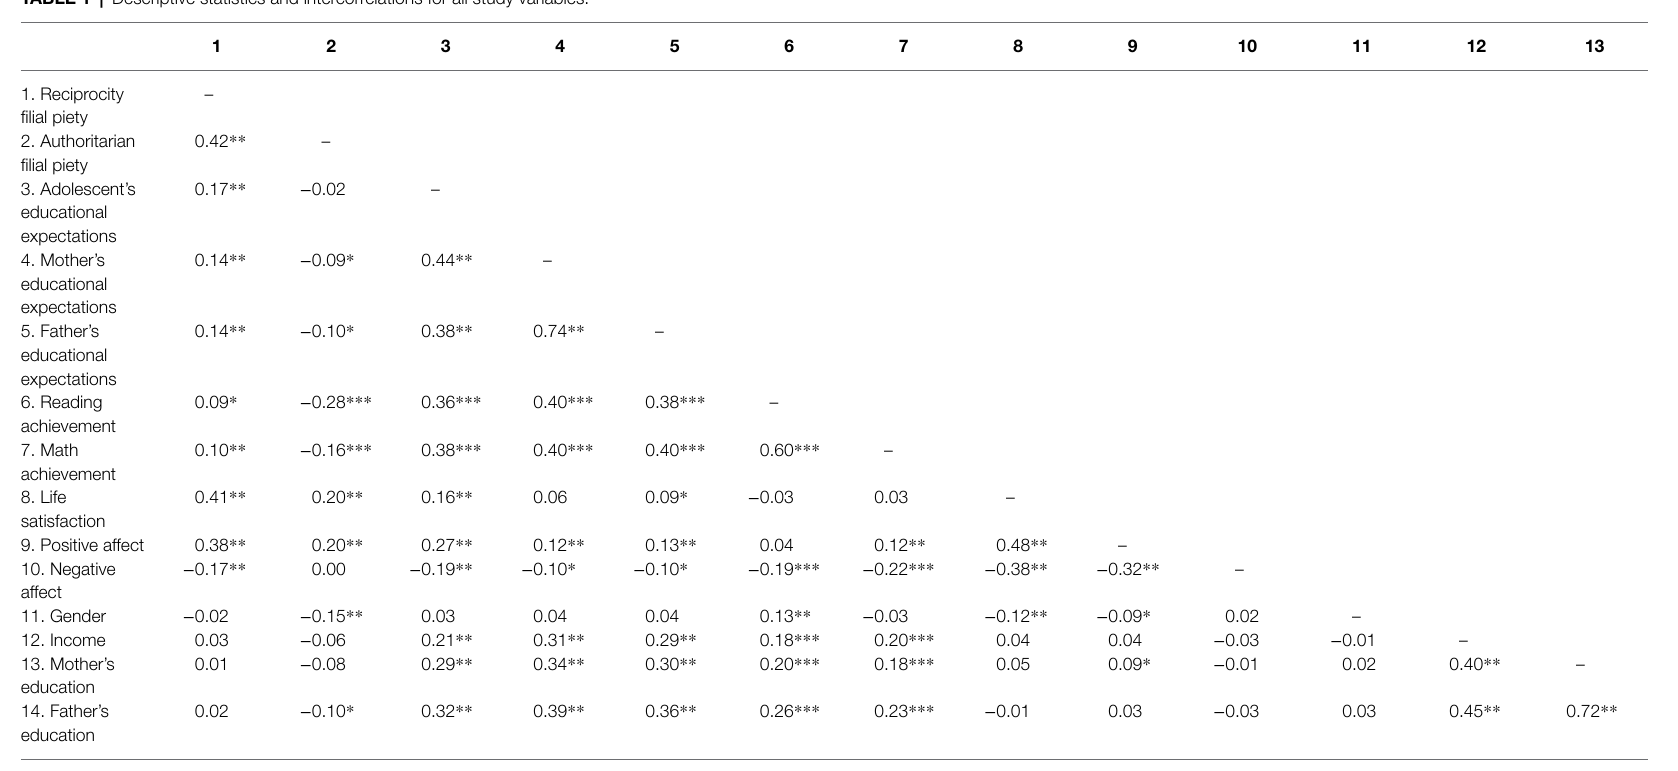
TABLE 1 | Descriptive statistics and intercorrelations for all study